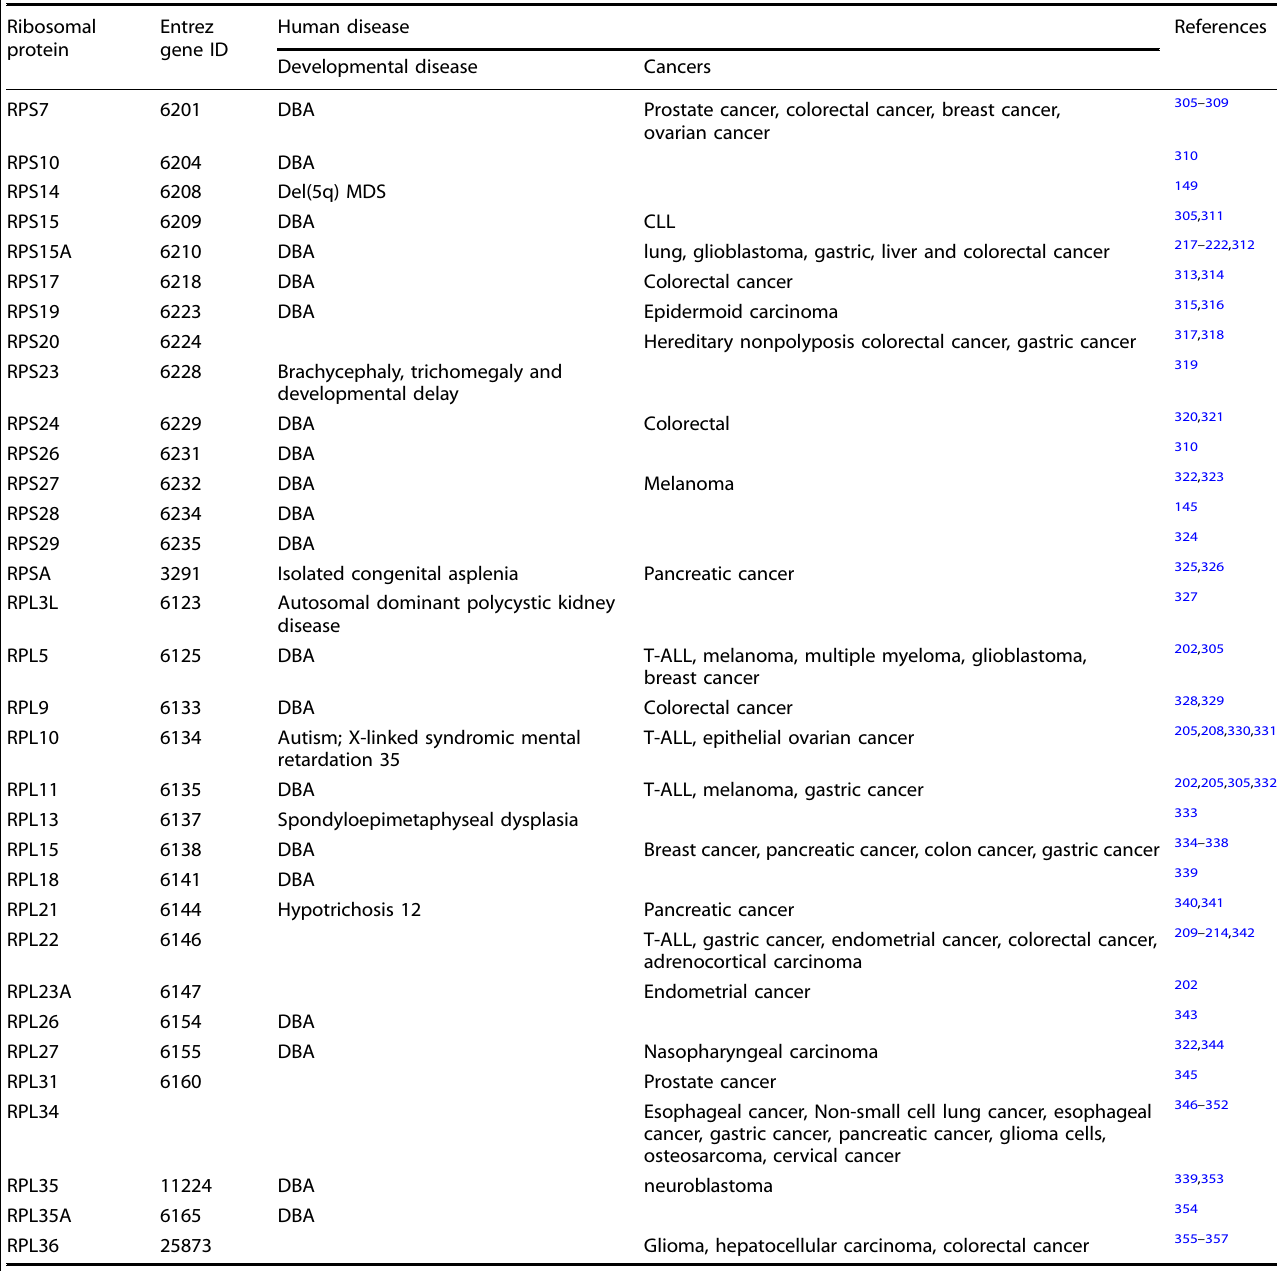
Table 1. Ribosomal proteins and human disease Ribosomal protein